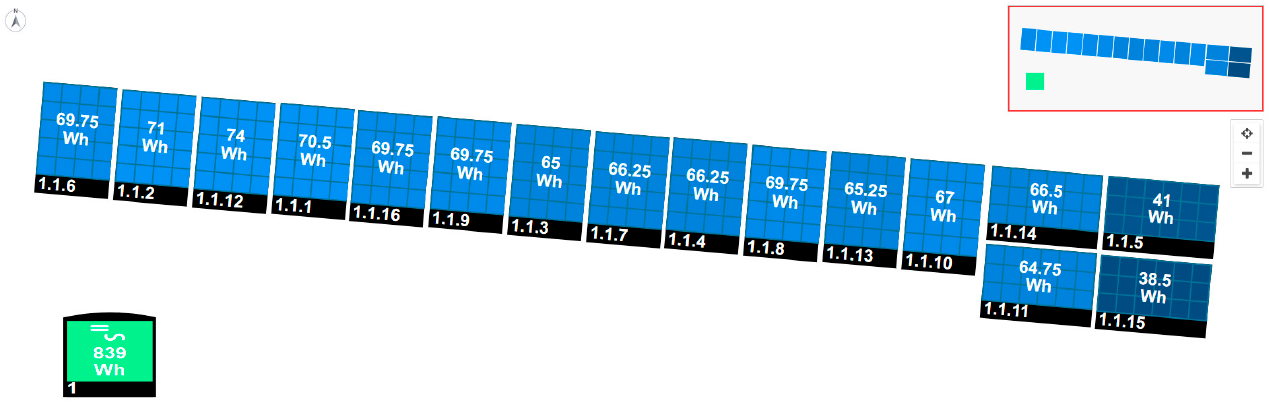
Figure 2. PV panels of the roof of Wroniecka 23 [36].